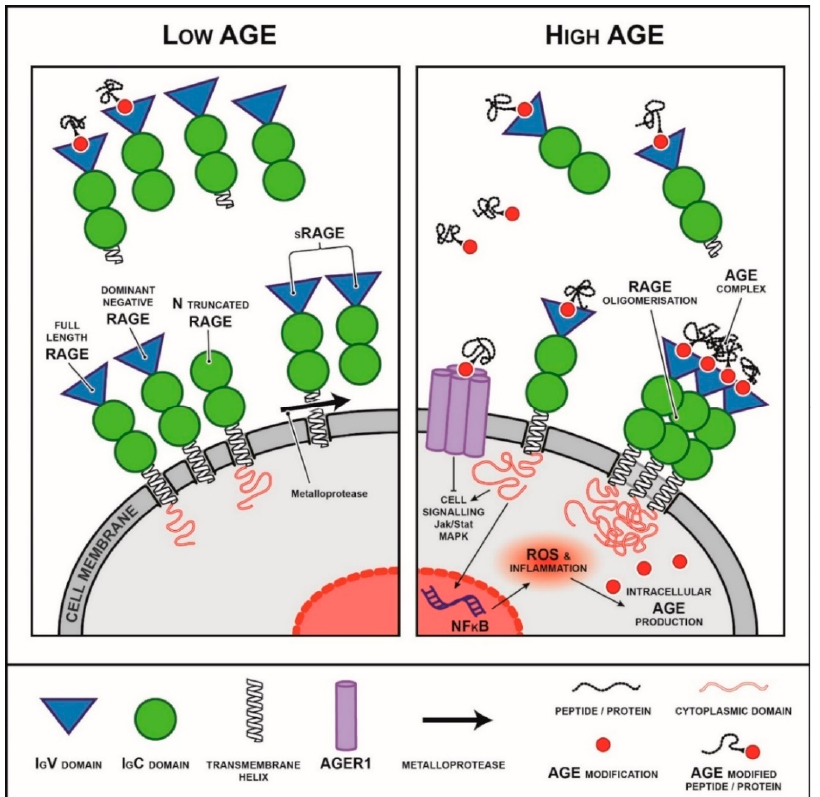
Figure 2. Isoforms of the receptor for AGEs (RAGE) and their interactions with AGEs and downstream pathways activated. RAGE is a multi-ligand member of the immunoglobulin superfamily of receptors. It can exist as different isoforms including membranous isoforms (full length RAGE, dominant negative RAGE, N truncated RAGE) as well as soluble secreted and cleaved isoforms. The cytoplasmic domain is essential for RAGE signalling. The secreted isoforms are thought to act as decoys, binding to RAGE ligands and preventing them from binding to membranous forms of RAGE activating downstream signalling. In a low AGE environment (left), circulating sRAGE is believed to act as a decoy receptor, binding circulating RAGE ligand such as AGEs and preventing binding to membranous isoforms of RAGE. In a high AGE environment (right), circulating sRAGE levels are commonly decreased or sRAGE capacity is saturated and is no longer sufficient to prevent RAGE downstream signalling.